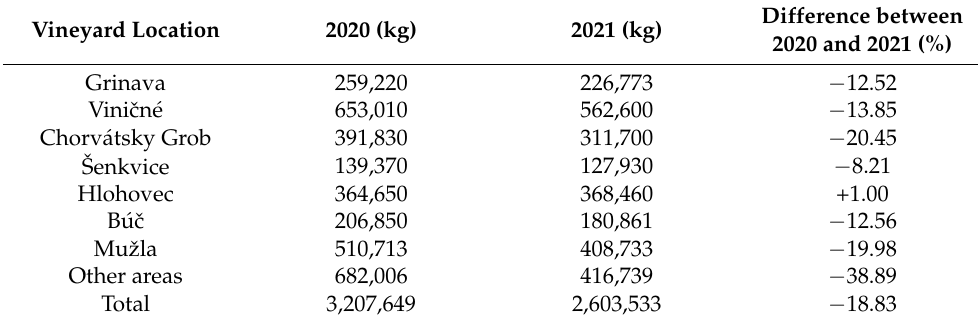
Table 2. Deliveries of grapes for 2020 and 2021